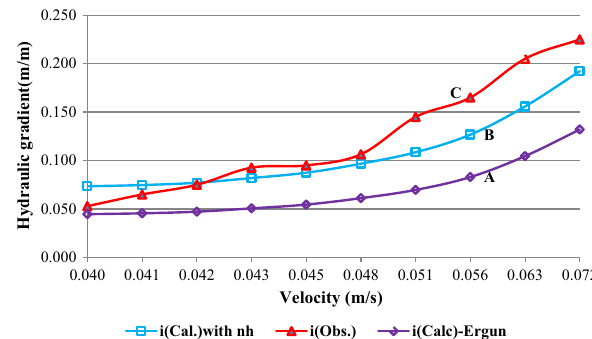
Fig. 13 Comparing plots of hydraulic gradient versus velocity for CGM2 series. Result is after 840 s of run start. Curve “A” shows vari- ations of ( i ) versus ( V ) based on common porosity concept, curve “B” shows variations of ( i ) versus ( V ) based on hydraulic porosity con- cept, curve “C” shows variations of ( i ) versus ( V ) based on actual model observations